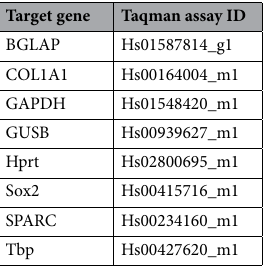
Table 2. Taqman assays used for